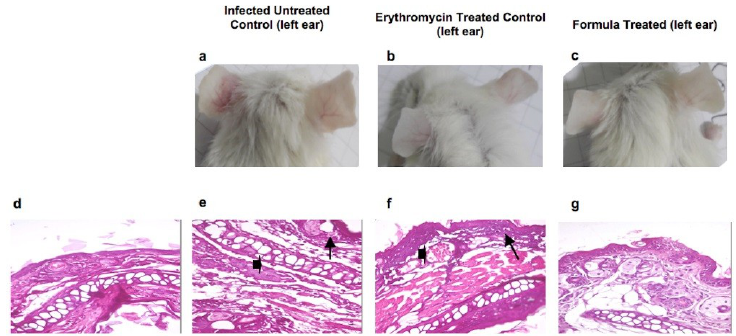
Figure 5. Oregano nanoemulsion as a potent anti‐acne agent tested in vivo model of P. acnes infection Photo images of BALB/c mice ear skin at the end of the experiment showing ( a ) untreated control mice, one ear injected with 20 µL of 10 8 CFU P. acnes suspension showing microcomedones and inflammation in infected left ear compared to the uninfected right ear; ( b ) inflammation in left infected ear disappeared after treatment with erythromycin solution comparable to the right uninfected ear; ( c ) absence of inflammatory appearance in left infected ear treated by oregano formula; ( d ) histopathological analysis of uninfected mice ear skin tissue stained with hematoxylin and eosin showing normal histology of mouse ear tissue with basal layer and epidermal cell maturation preserved; ( e ) histopathology of infected untreated control mice ear showing necrotic dermatitis character; note the severe dermal necrosis (arrow head), and lymphocytic infiltrate (arrow); ( f ) ear showing acute dermatitis character; note the congested blood vessels (arrow head), and slight lymphocytic cells infiltration (arrow) treated by erythromycin solution; ( g ) ear showing apparently normal histology of mouse ear tissue with the absence of inflammatory reaction, treated with oregano formula.